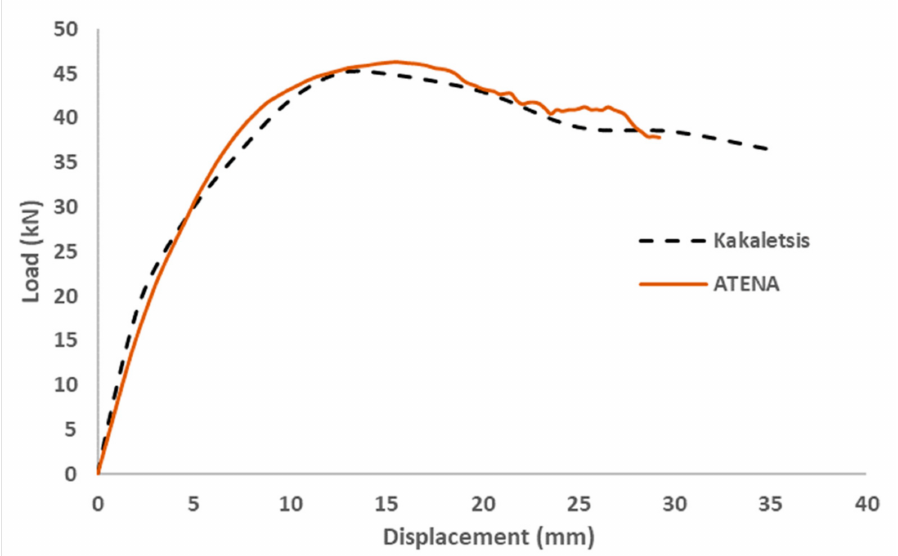
Figure 4. Load-displacement of the building